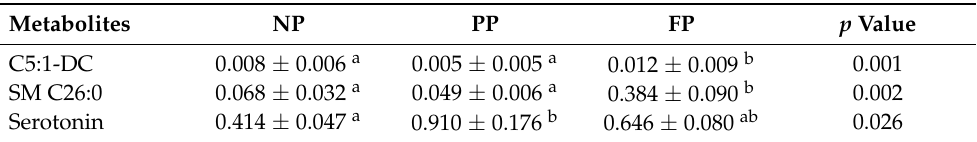
Table 3. Plasma significant metabolites ( µ M; mean ± standard error) of bulls in the rearing phase submitted to the different prenatal nutrition approaches (NP, PP, and FP) with their respective p values.